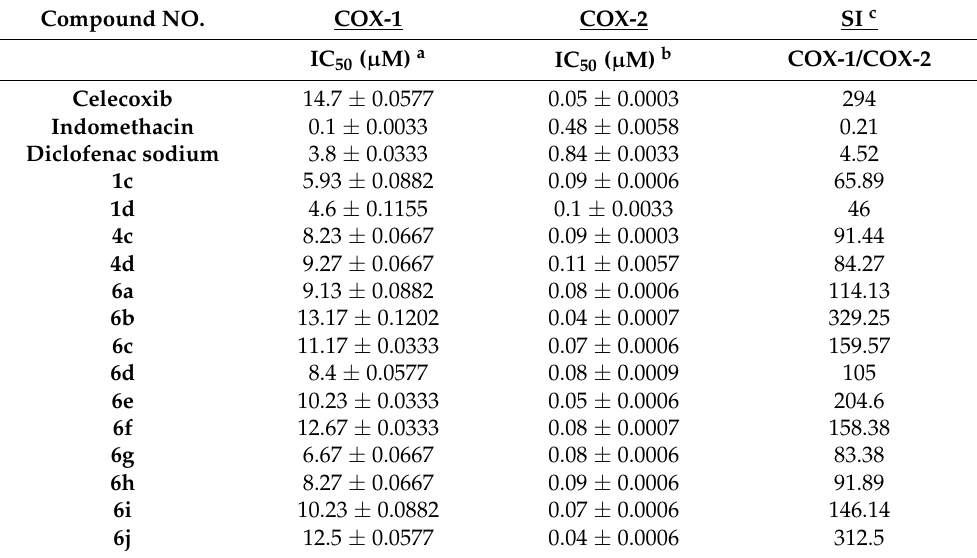
Table 1. In vitro human COX-1/COX-2 enzymatic inhibitory activities and COX selectivity indices of the newly synthesized compounds. Compound